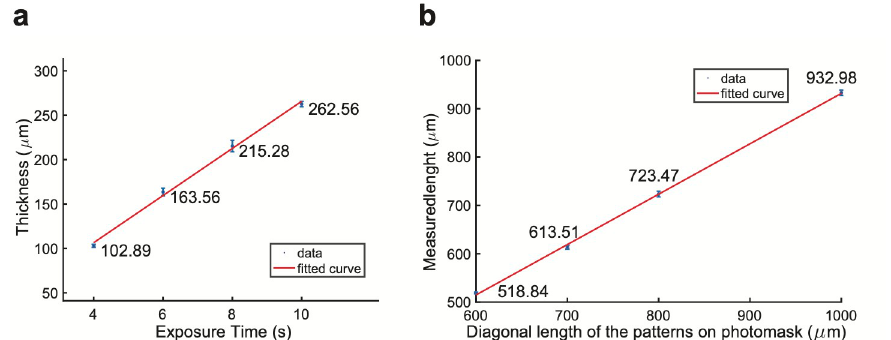
Fig 3. Characterization of micropatterned PEGDA gel thickness and cell pattern size. ( a ) Measurement of thickness of gel bed using different UV exposure time in fabrication. Unit: μ m. The linear polynomial curve fitted to the data points has the equation of val(x) = p1 � x + p2, where coefficients (with 95% confidence bounds) are p1 = 26.54 (21.93, 31.14), p2 = 0.317 (-33.53, 34.16). ( b ) Measurement of the sizes of circular cell patterns. All gels used were exposed to UV for 6 s. Major axis length of each cell colony was acquired, which represents the measured size of the cell pattern. Unit: μ m. The linear polynomial curve fitted to the data has the same equation of val(x) = p1 � x + p2, but with coefficients (with 95% confidence bounds) p1 = 1.042 (0.9707, 1.114) and p2 = -110.5 (-167,